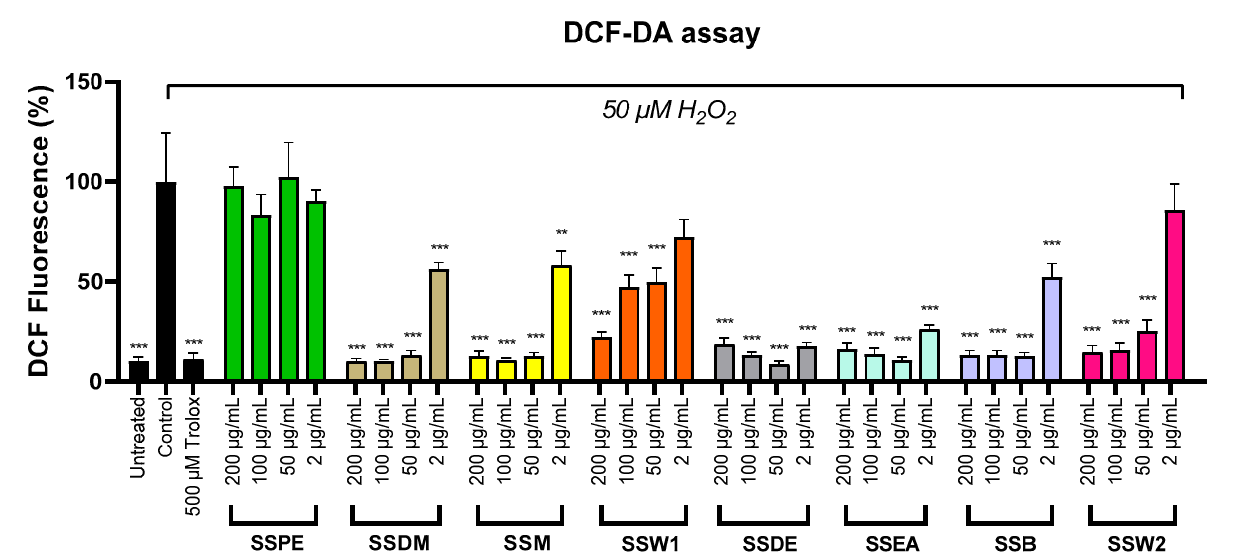
Figure 2. Effect of SS fractions on H 2 O 2 -induced oxidative stress in SH-SY5Y cells. The standard error of the mean (SEM) for five separate studies is displayed in the error bars. When compared to control cells incubated with 50 µM H 2 O 2 alone, the symbols **, and *** indicate statistical importance at p < 0.01, and p < 0.001, respectively.